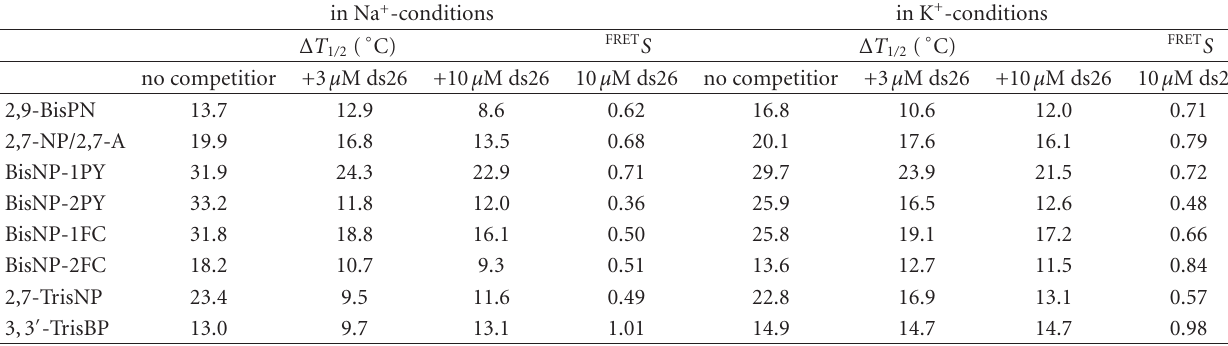
Table 1: Competitive FRET-melting results of the 8 ligands selected after the second selection step. in Na + -conditions in K +